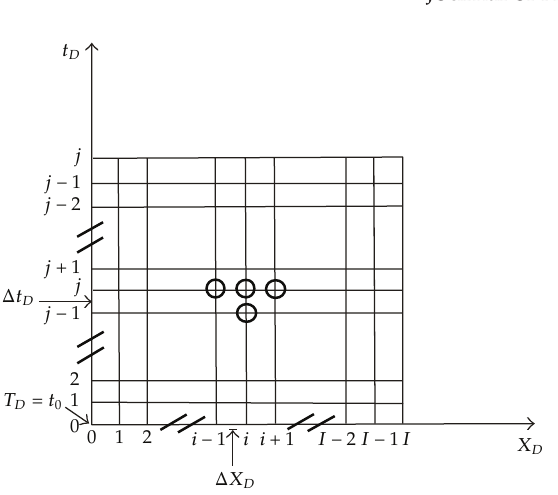
Figure 2: Representation of grid blocks used in the simulation: calculation of the q D at a new time step from the q D at the previous time step.